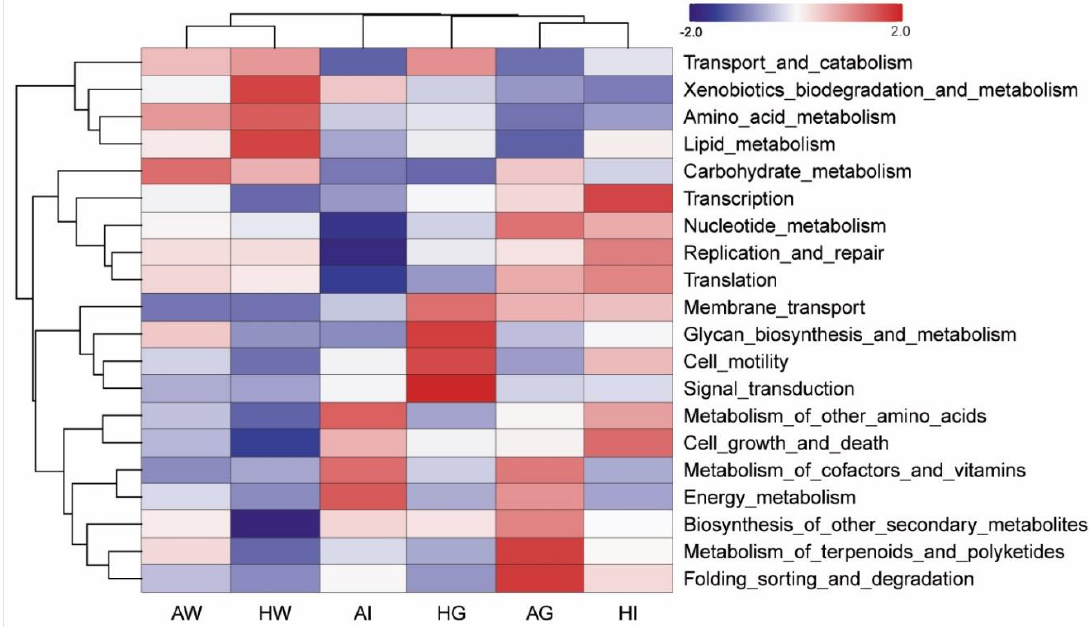
Figure 7. Heatmap showed the top 20 microbial functions of all fish samples at KEGG-2-level. AI: intestinal samples of fish from zone A; AG: gill samples of fish from zone A; HI: intestine of fish from zone H; HG: gill of fish from zone H; AW: water samples from zone A; HW: water samples from zone H.